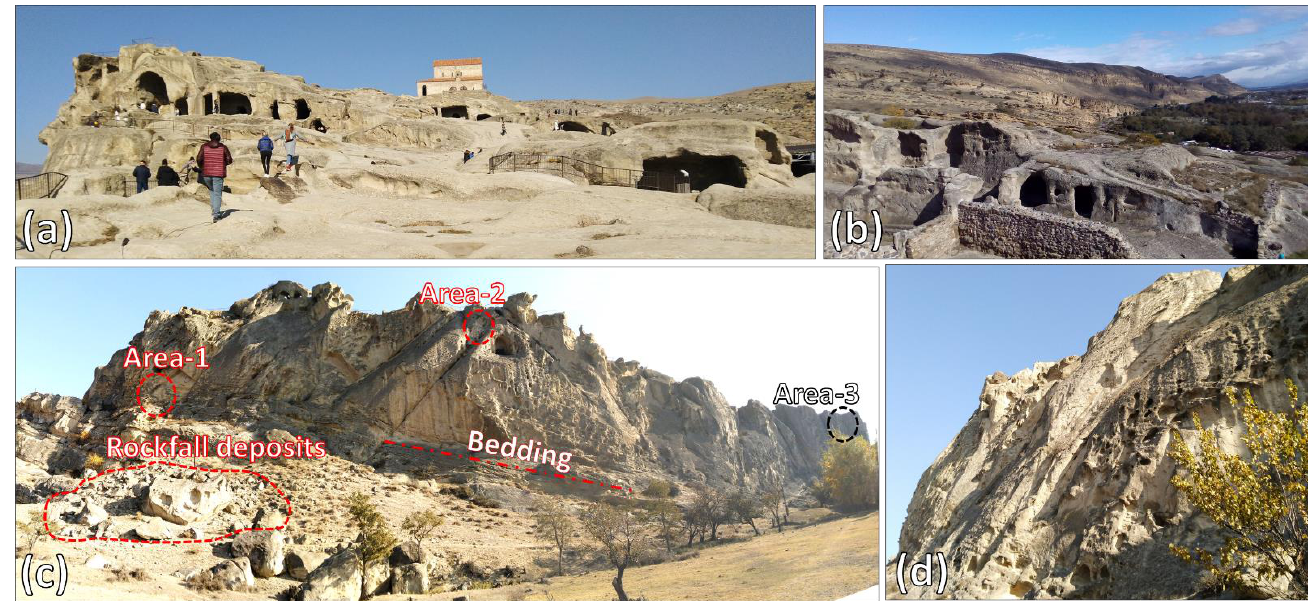
Figure 4. The Uplistsikhe cave town complex: top of the rocky terrace with the brick church ( a ); examples of cave systems and defensive walls ( b ); the unstable rock cliff bordering the site (red dashed circles highlight April 2019 detachments, Areas 1 – 2, the black circle the one from July 2019, Area 3) ( c ); examples of sandstone wind weathering (corrasion) ( d ).